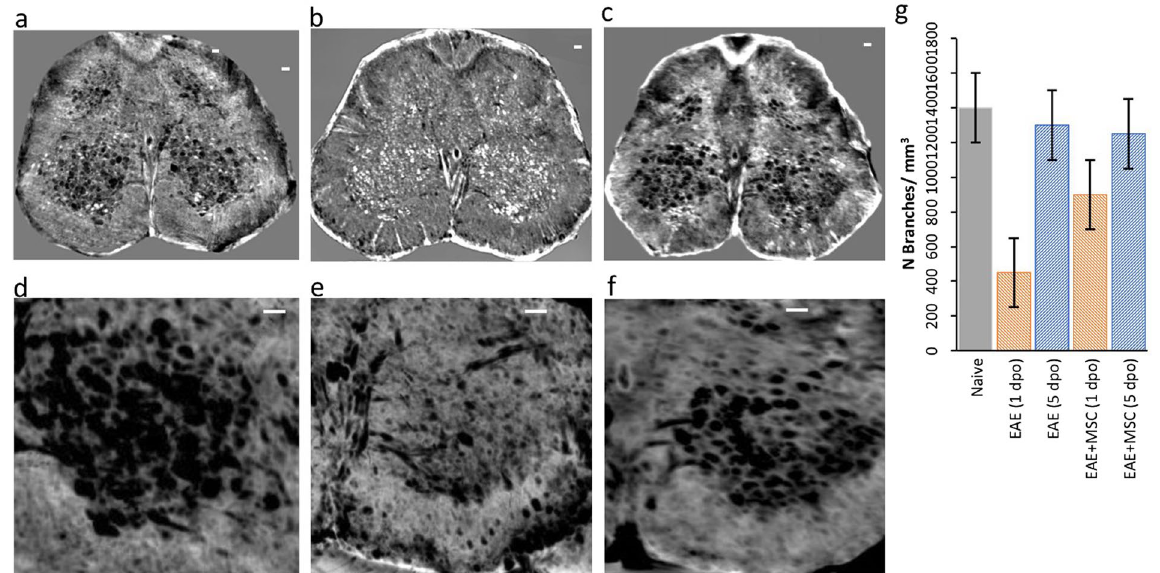
Figure 1. Vascular alteration at the initial phase of EAE. Axial projections of XPCT images of the spinal cord in healthy ( a , d ), EAE-affected ( b , e ), and EAE-affected MSC-treated ( c , f ) mice. The pixel size is 3.5 microns and the spatial resolution is 7 microns. The figures show tomography of 1.5 × 1 × 1 mm 3 volume; ( d – f ) are the segmentation of the vasculature (rendered in black) of ( a – c ) respectively. Scale bar = 20 μ m. The red arrow in ( a ) indicates the anterior spinal artery ( g ) Quantification of the number of vessel branches in lumbar spinal cord samples from naïve and EAE-affected mice at 1 dpo (red) and 5 dpo (blue), with and without MSC treatment (n = 3 per group). The data are presented as mean ± SD. The corresponding tomographic images of EAE spinal cord at 5 dpo are presented in Fig.